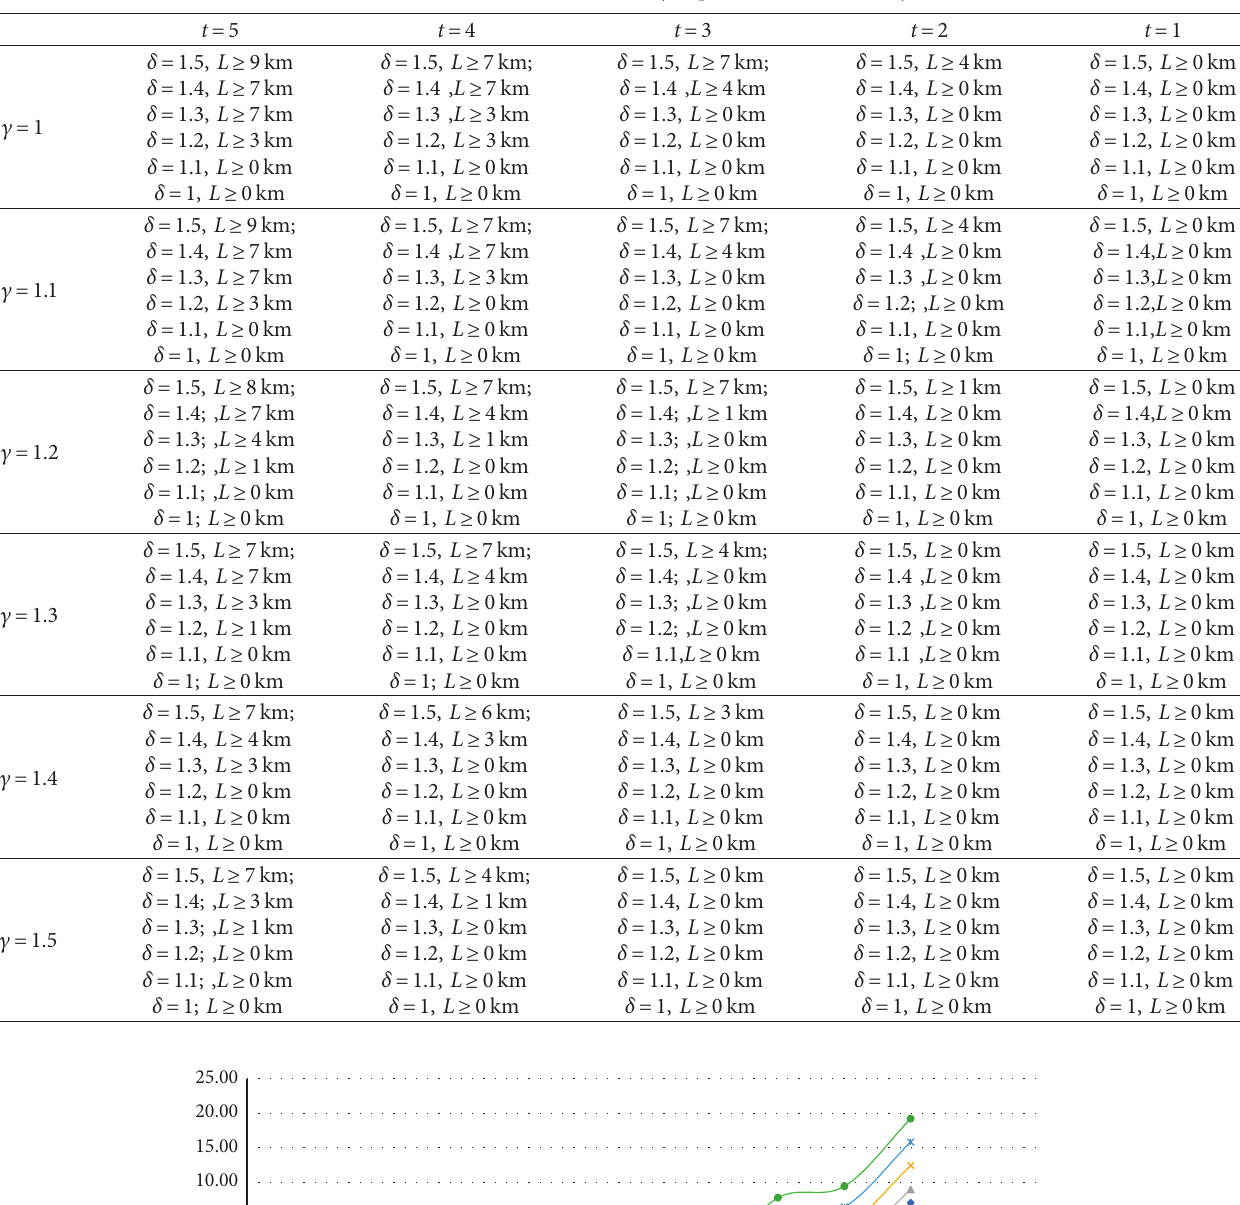
Table 11: Scenarios of drone delivery superior to rider delivery.